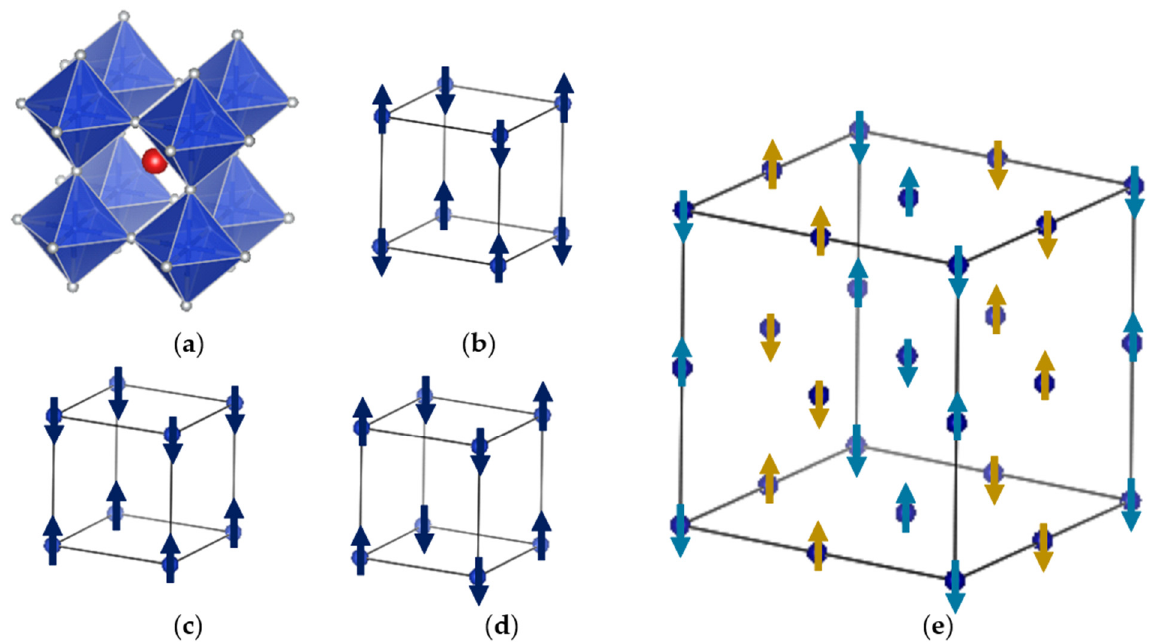
Figure 1. Sketch of the AFM structures encountered in hole-doped CMR manganites at different doping levels. ( a ) Representation of a simple perovskite REMnO 3 , in which each Mn cation (at the center of octahedra) interacts magnetically with six first neighbors through oxygen atoms (small gray balls); the RE cation (red ball) is at the center of the unit cell. ( b , d ) Most common AFM structures (only the Mn species are represented, with magnetic moments shown as arrows pointing up and down): ( b ) G-type structure, typical of x = 1 compositions with only not Jahn–Teller active Mn 4+ ions, in which all six first neighbors are antiferromagnetically coupled through Anderson superexchange interactions. ( c ) A-type and ( d ) C-type AFM structures, with, respectively, four over six and two over six ferromagnetic interactions, found when all (or the great majority) of Mn species are instead Jahn–Teller active Mn 3+ . ( e ) CE-type charge and orbitally ordered AFM phase typical of half-doped compositions. Mn 3+ and Mn 4+ magnetic moments are represented by arrows of different colors (Mn 4+ blue arrows, Mn 3+ yellow arrows).